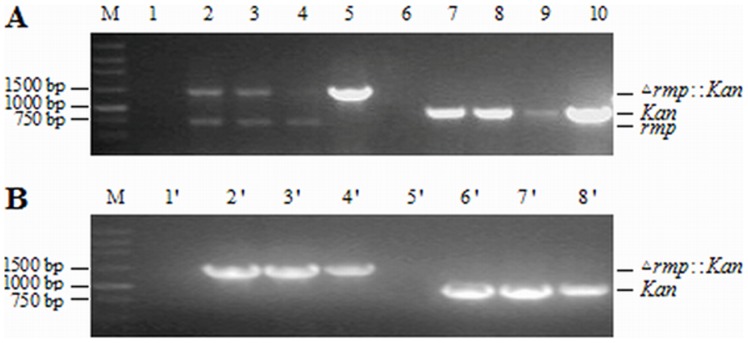
PCR identification of N. gonorrhoeae Rmp deletion mutants in the 1st (A) and the 7th (B) generation of transformants.The cultures of relevant strains were amplified using rmp primers (rmpF and rmpR) and Kan primers (KanF and KanR), respectively. Lanes 1, 6, 1’ and 5’ represent negative controls using pMD19-T as templates; lanes 5, 10, 4’ and 8’ represent positive controls using pMD19Δrmp::Kan as templates.